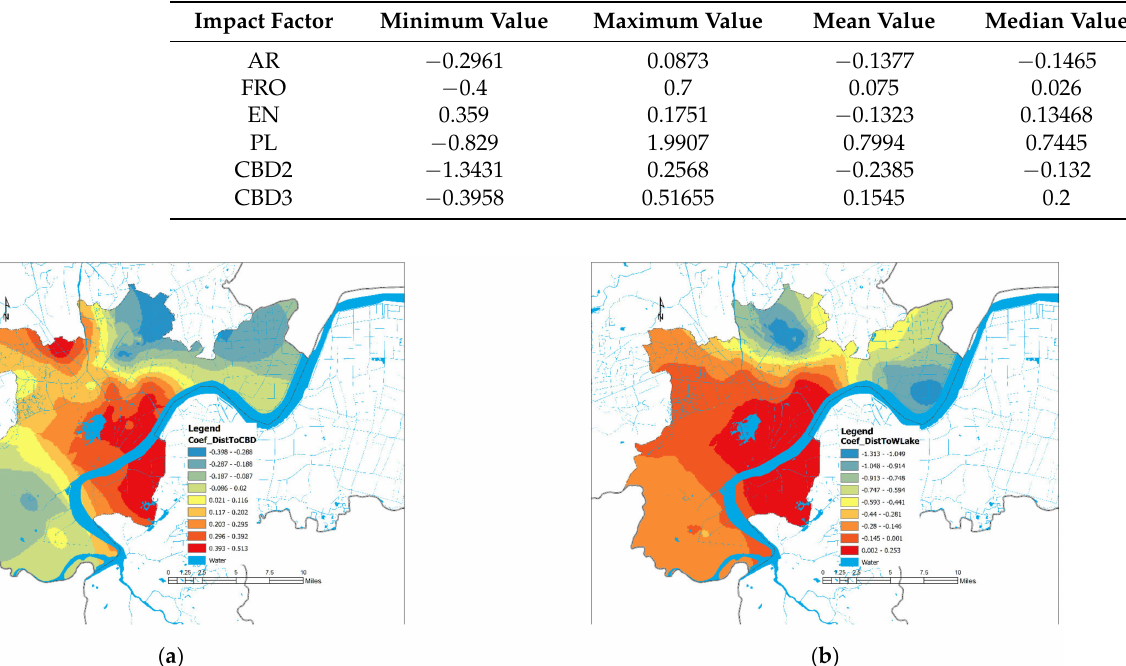
Figure 7. ( a ) Plot of distance to CBD coefficient diagram of commercial land category 1; ( b ) Plot of distance to West Lake coefficient diagram of commercial land category